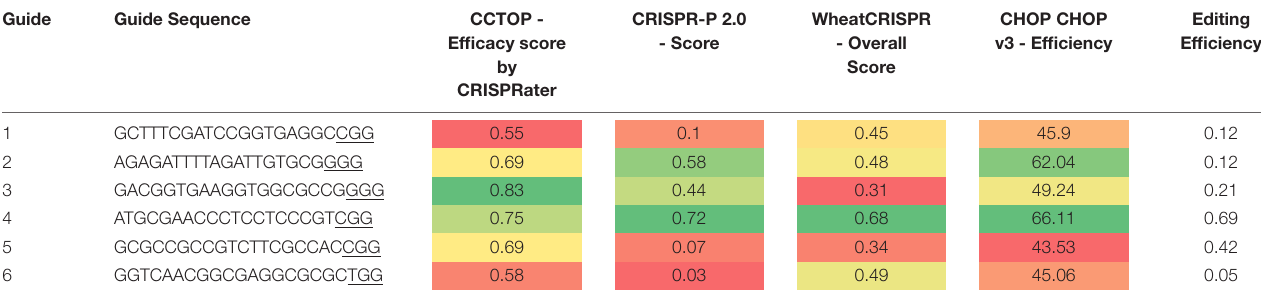
Colors in each column indicate relative predicted efficiencies using each program with green denoting the highest and red the lowest score.